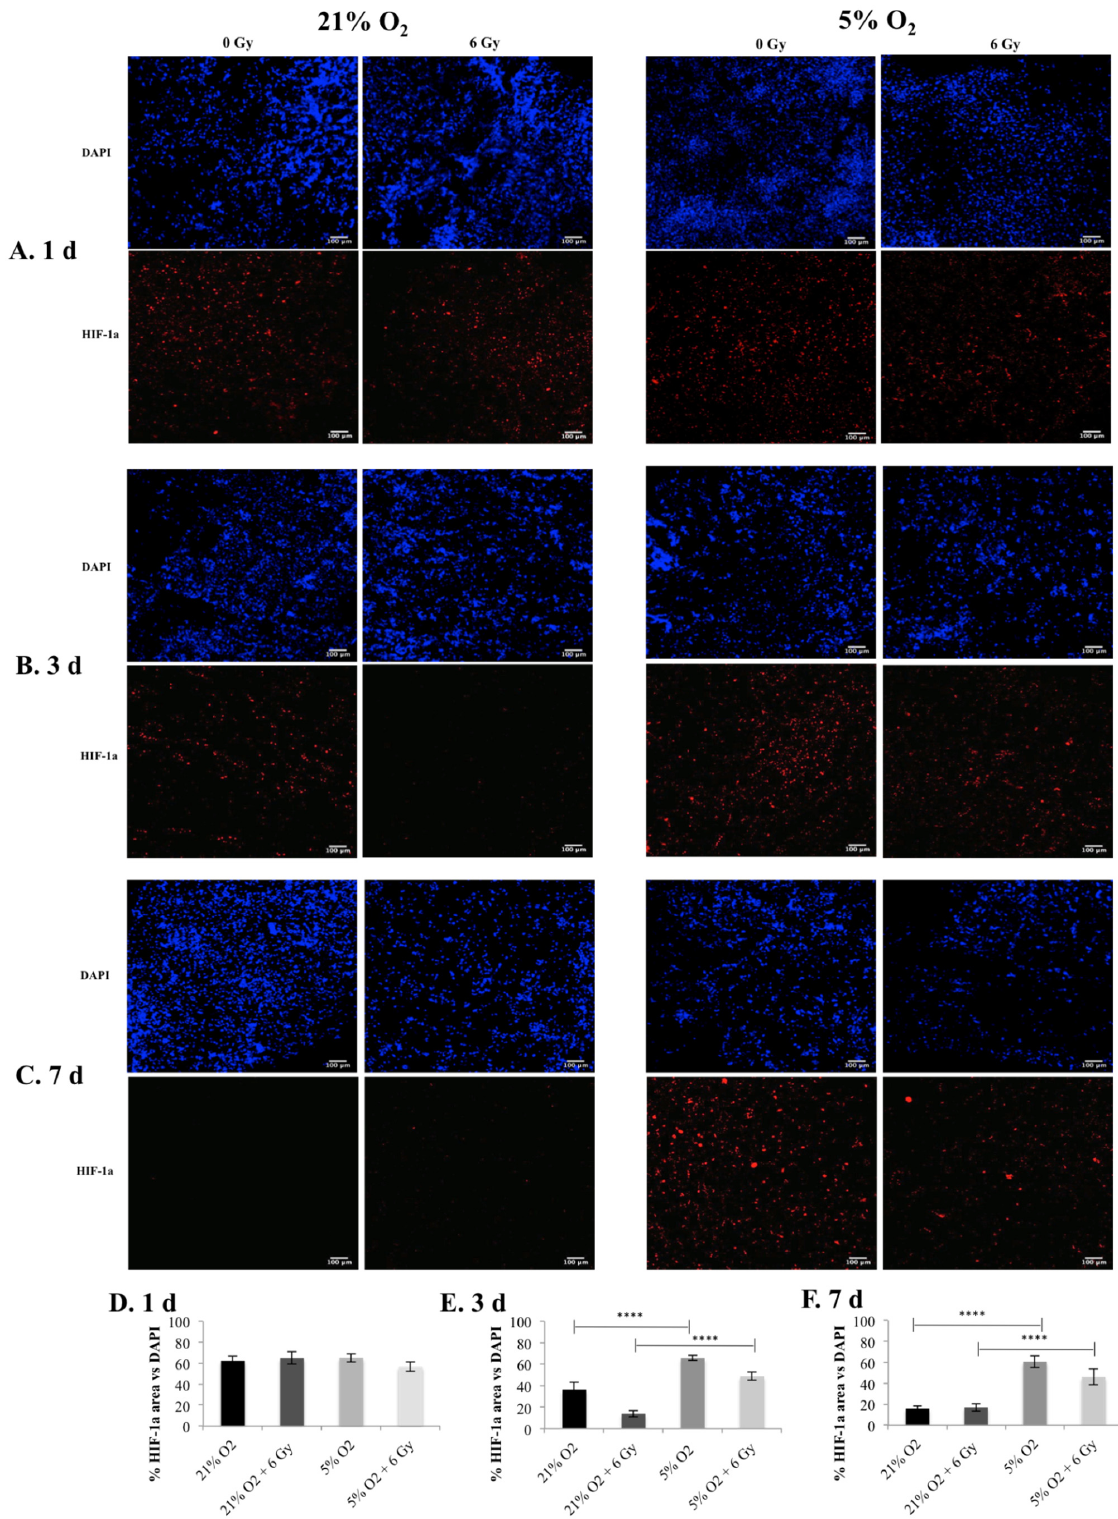
Figure 1. HIF-1a expression following radiotherapy treatment (6 Gy) in 3D scaffolds for 21% O 2 and 5% O 2 : ( A – C ) Repre- sentative images of scaffold sections for HIF-1a (red) staining, counterstained with DAPI (blue) at 1 day, 3 days, and 7 days post radiation treatment. ( D – F ) Equivalent image analysis based quantification of the percentage of HIF-1a positive image areas over total cell (blue) image areas (DAPI) for 1 day ( D ), 3 days ( E ), and 7 days ( F ) post radiation treatment. Multiple scaffolds (3), scaffold sections (3), and images (2) were analysed, mean values are presented. (**** = p <